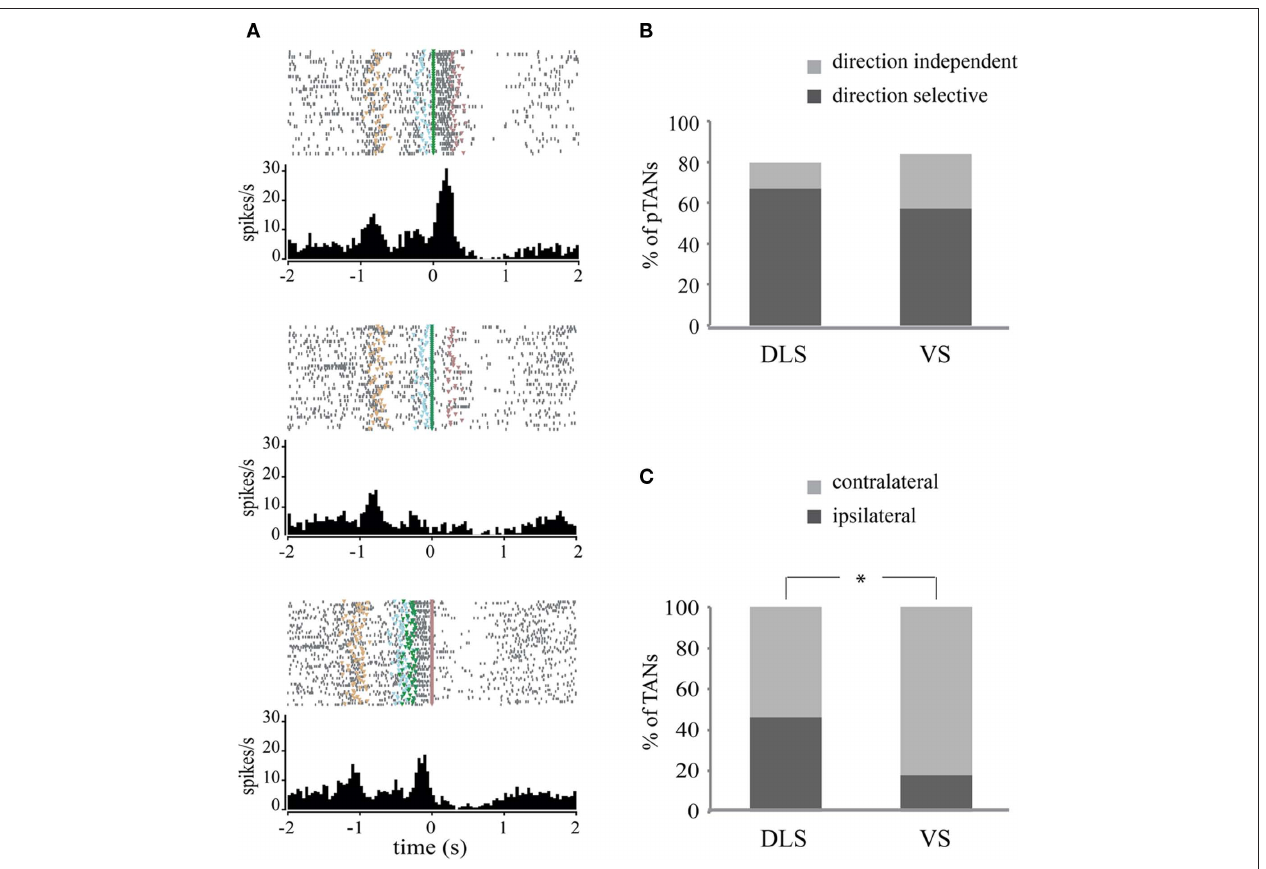
marked in violet. Top panel: plot is aligned to the beginning of movement toward the left side; middle: plot is aligned to beginning of movement to the right side; bottom: plot is aligned to reward. (B) Percent of movement related and direction selective pTANs in DLS and VS. (C) Percent of direction selective pTANs in which the preferred direction was contralateral or ipsilateral to the